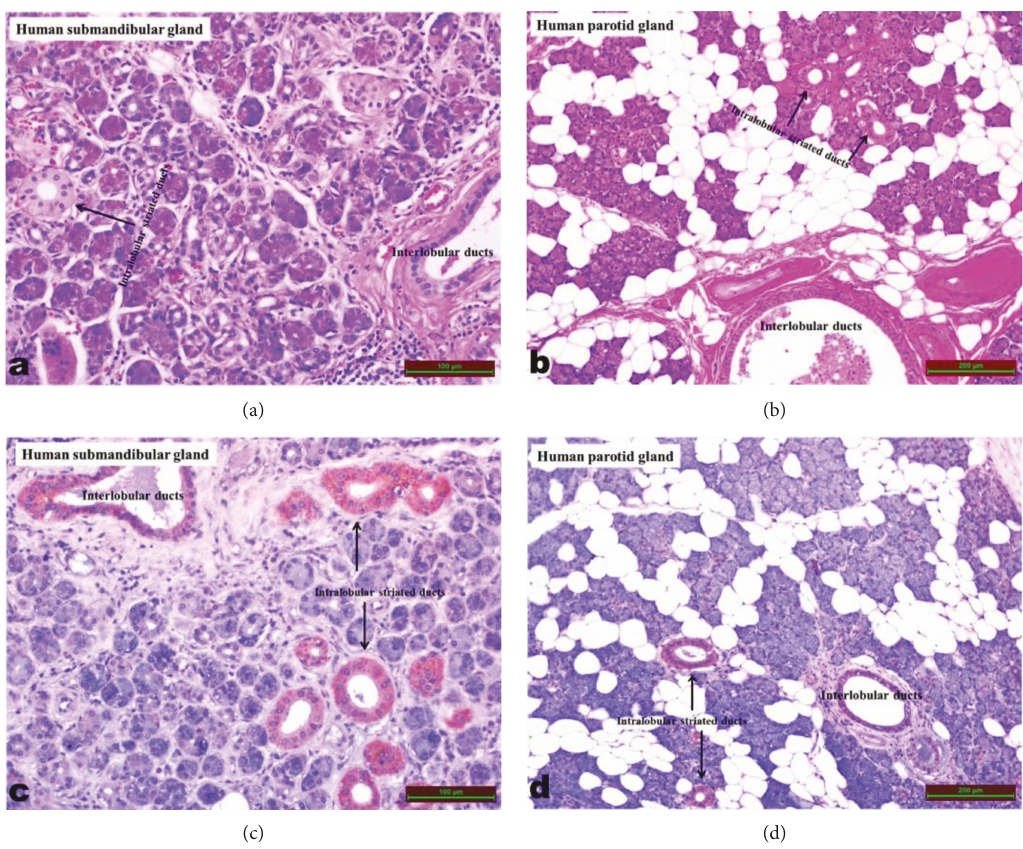
Figure 3: Asprosin immunoreactivity in human submandibular and parotid salivary glands (intralobular striated ducts and interlobular ducts of submandibular and parotid salivary glands). Red-colored areas (arrows) indicate asprosin